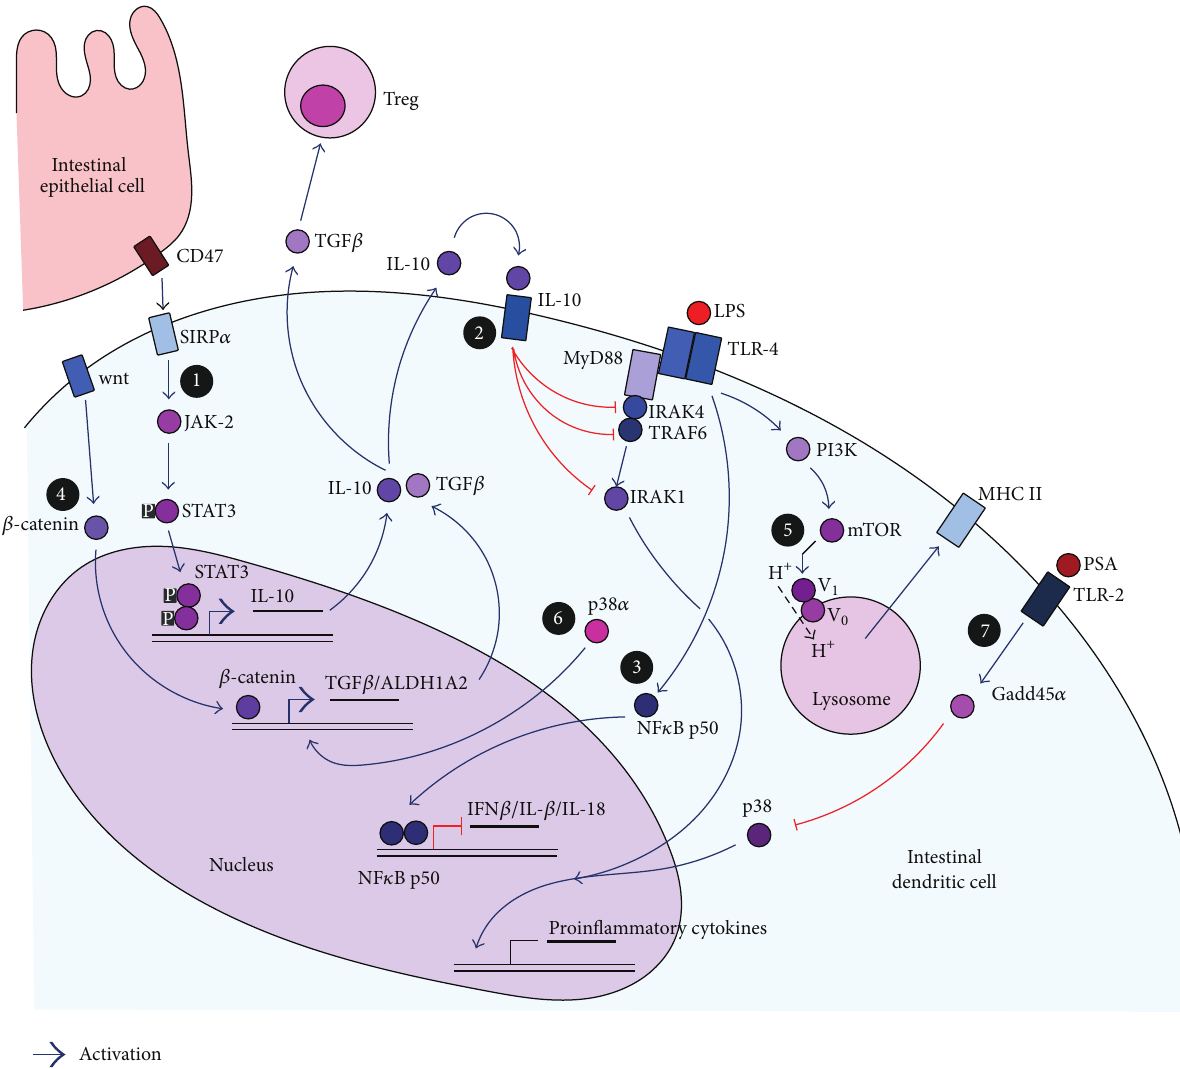
Figure 2: Possible molecular mechanisms of tolerance induction in intestinal dendritic cells. The white numbers in black circles refer to the numbering of regulation mechanisms in the text. See text for